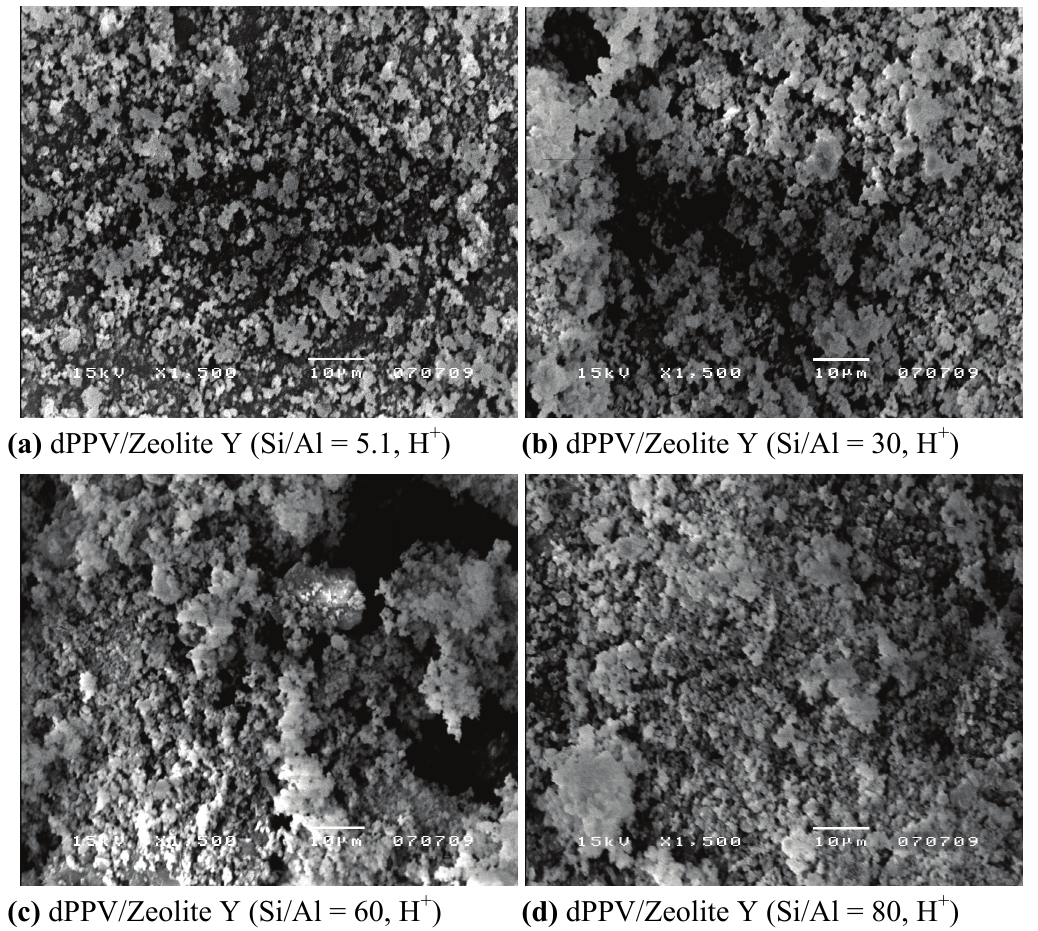
Figure 1. SEM micrographs of the dPPV/zeolite Y composites having different Si/Al ratios (magnification 1,500, 15 kV).